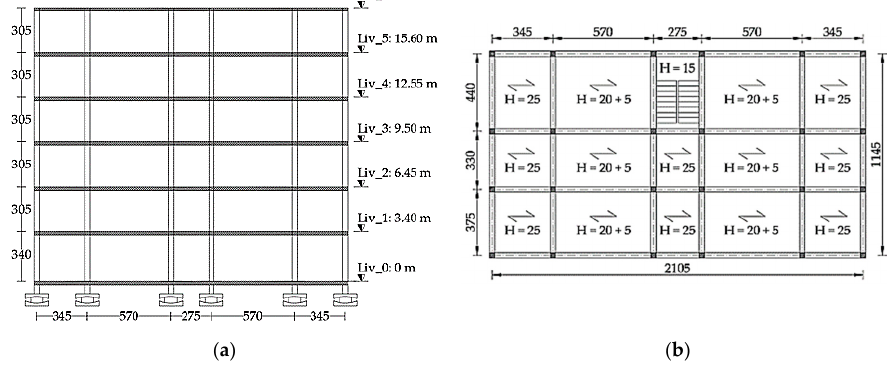
Figure 1. New construction isolated building: ( a ) side and ( b ) floor